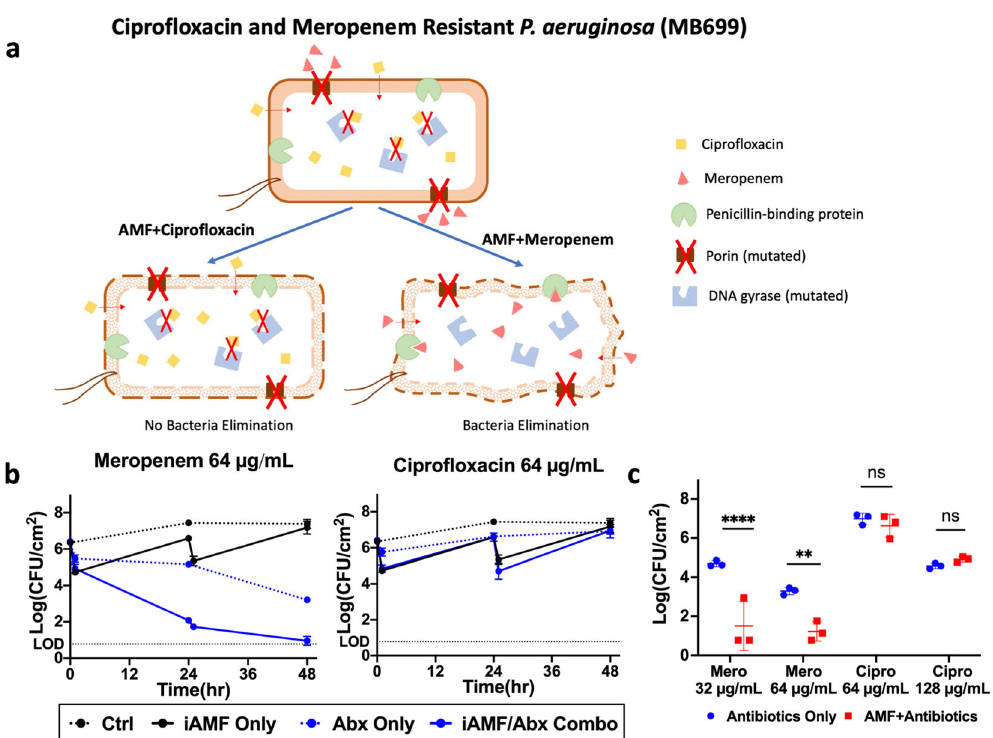
Fig. 7 iAMF can rescue MDR pathogens depending on the mechanism of resistance. MDR P. aeruginosa (MB699) bio fi lm was treated with meropenem (MIC 64 μ g mL − 1 ) or cipro fl oxacin (MIC 64 μ g mL − 1 ) with or without iAMF (dosed at 0 and 24 h, N exp = 12, T max = 65 °C, Δ t exp = 5 min) while incubating with antibiotic for 48 h. a Proposed mechanism for sensitization of antibiotic-resistant bio fi lm to meropenem by AMF. b Treatment time course with meropenem (left) or cipro fl oxacin (right) at 64 μ g mL − 1 . Colony-forming units (CFU) were counted at time points of 0, 24, and 48 h. c Log reduction of antibiotic-resistant bio fi lm at different concentrations of cipro fl oxacin or meropenem at 48 h post start of treatment. n = 3. Error bars indicate SD. CFU limit of detection (LOD) = 0.78 log(CFU cm − 2 ). Two-way ANOVA. Statistical signi fi cance: not signi fi cant (ns), p = 0.001 (**), and p < 0.0001